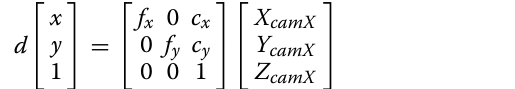
algorithm 1 extracts the element σ detect of L X and the ele- ment σ target of L All . Next, in the seventh line, if the dis- tance between each element σ is less than 0.05 [m],